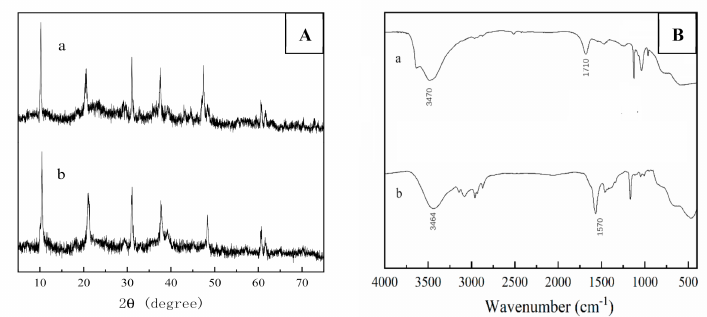
Figure 7. XRD patterns ( A ) and FT-IR spectra ( B ) of five times reused catalyst ( a ) and fresh catalyst ( b ).